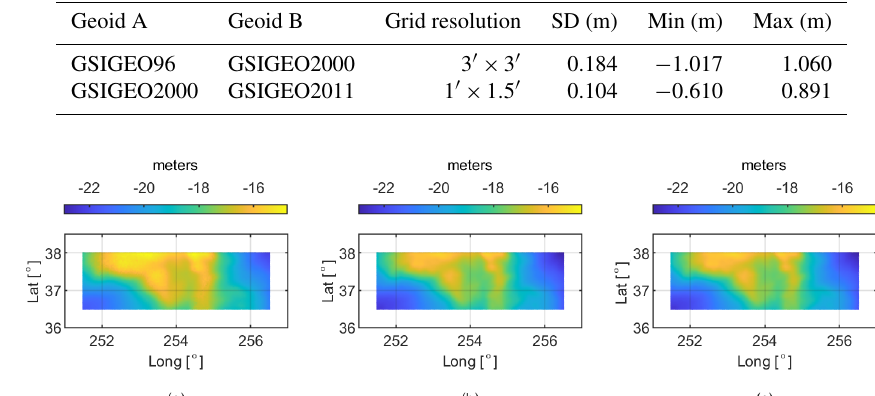
Table 2. Statistics of the differences between the analysed Japanese geoids.